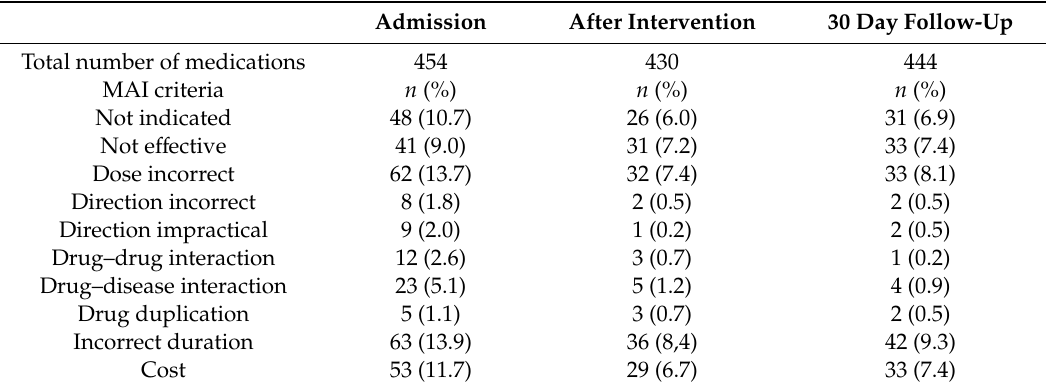
Table 3. Individual Medication Appropriateness Index (MAI) criteria deemed inappropriate at admission, after intervention, and 30 days after